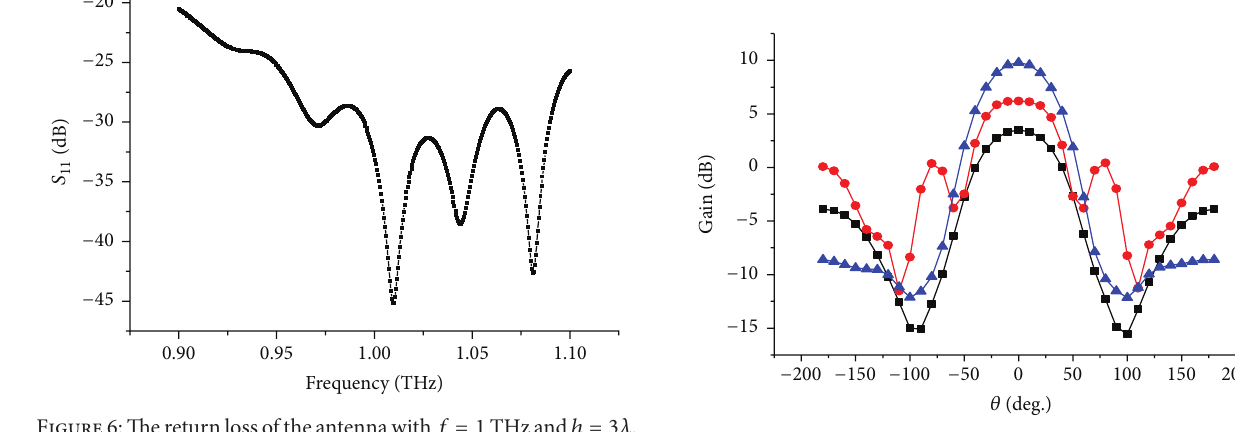
Figure 6: The return loss of the antenna with 𝑓 = 1 THz and ℎ = 3𝜆 .